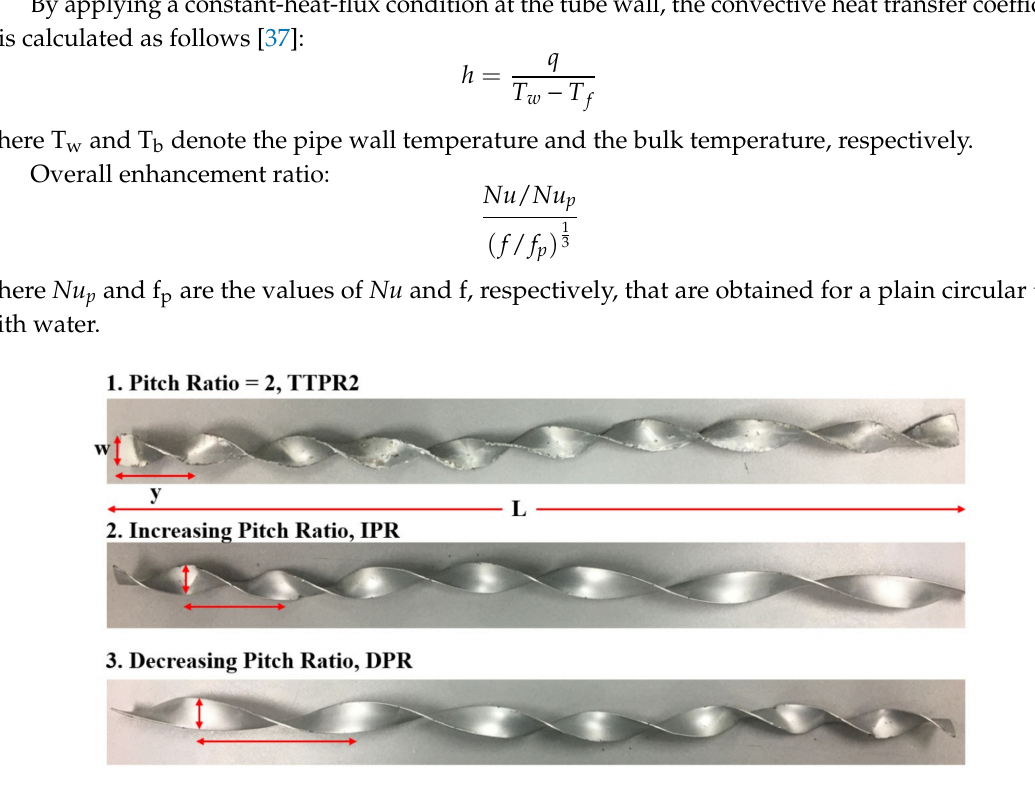
Figure 11. Geometries of twisted